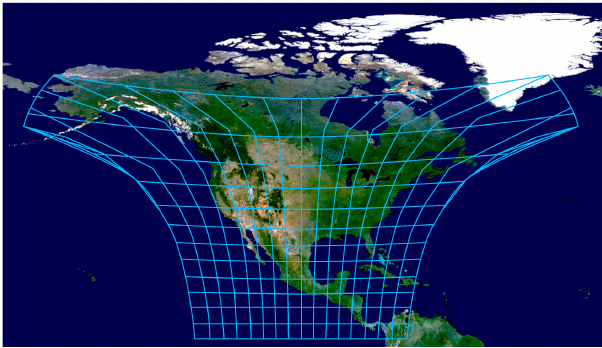
Figure 8. CHRONOS field of view from geostationary orbit at 100 ◦ W. Each grid cell above represents 125 × 125 pixels. All pix- els are acquired with full precision within the ∼ 10min CHRONOS data